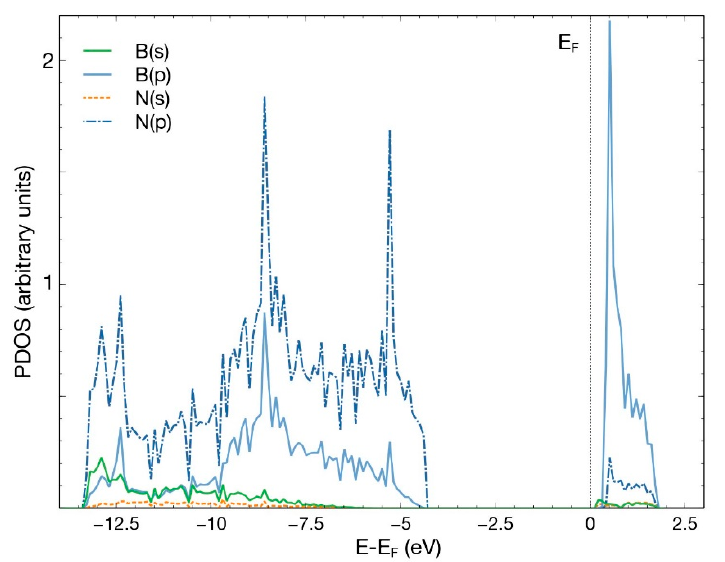
Figure 2. PDOS for the pristine hBN surface, consisting of 50 atoms. The hybridization of states s and p of boron and nitrogen is evident.